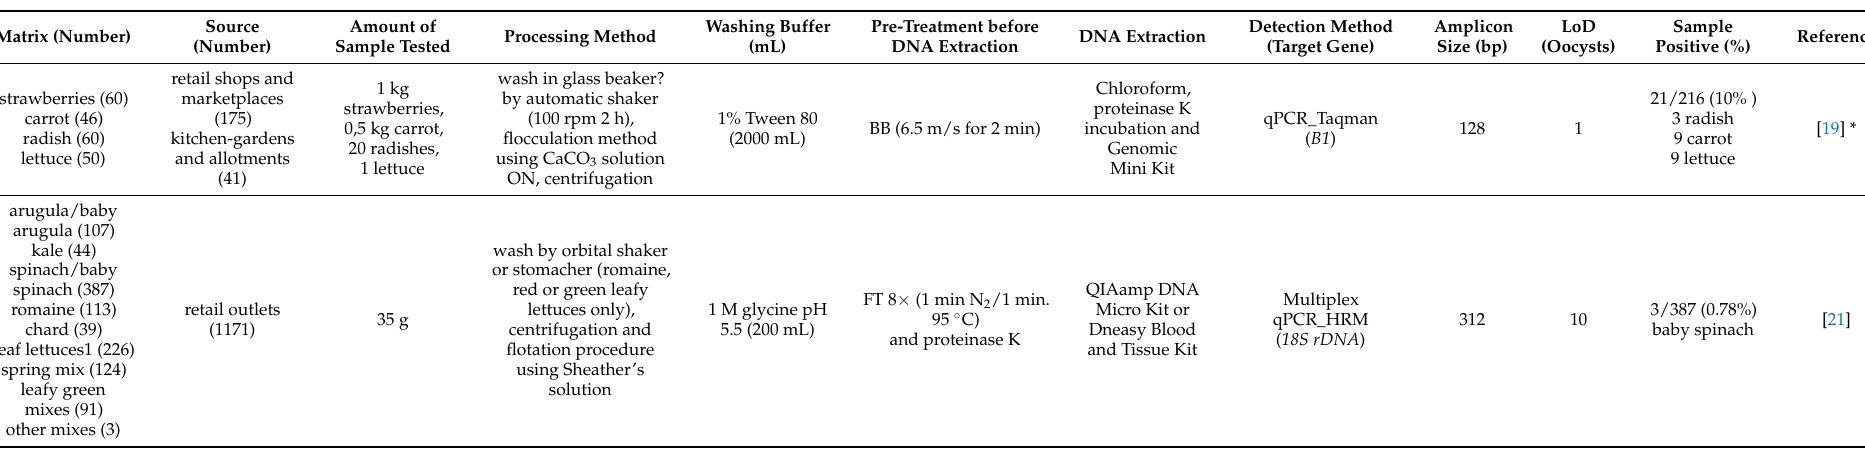
Table 2. Published methods for the molecular detection of Toxoplasma gondii in fresh produce that have been used in